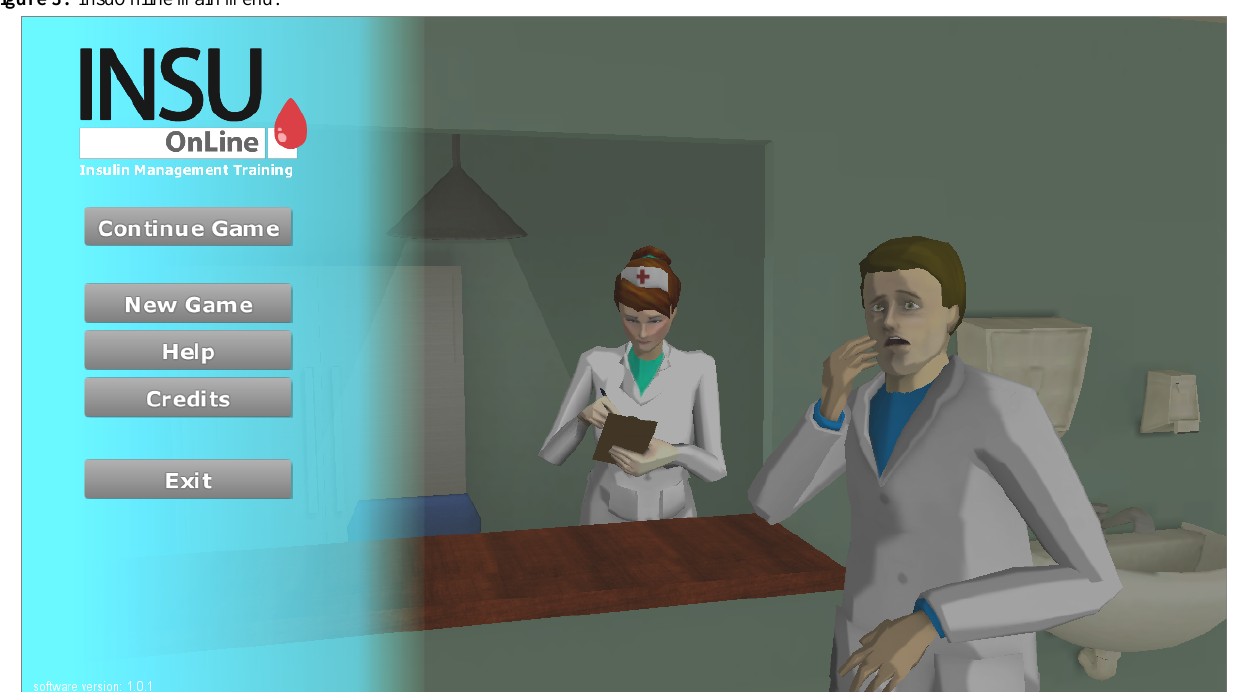
Figure 3. InsuOnline main